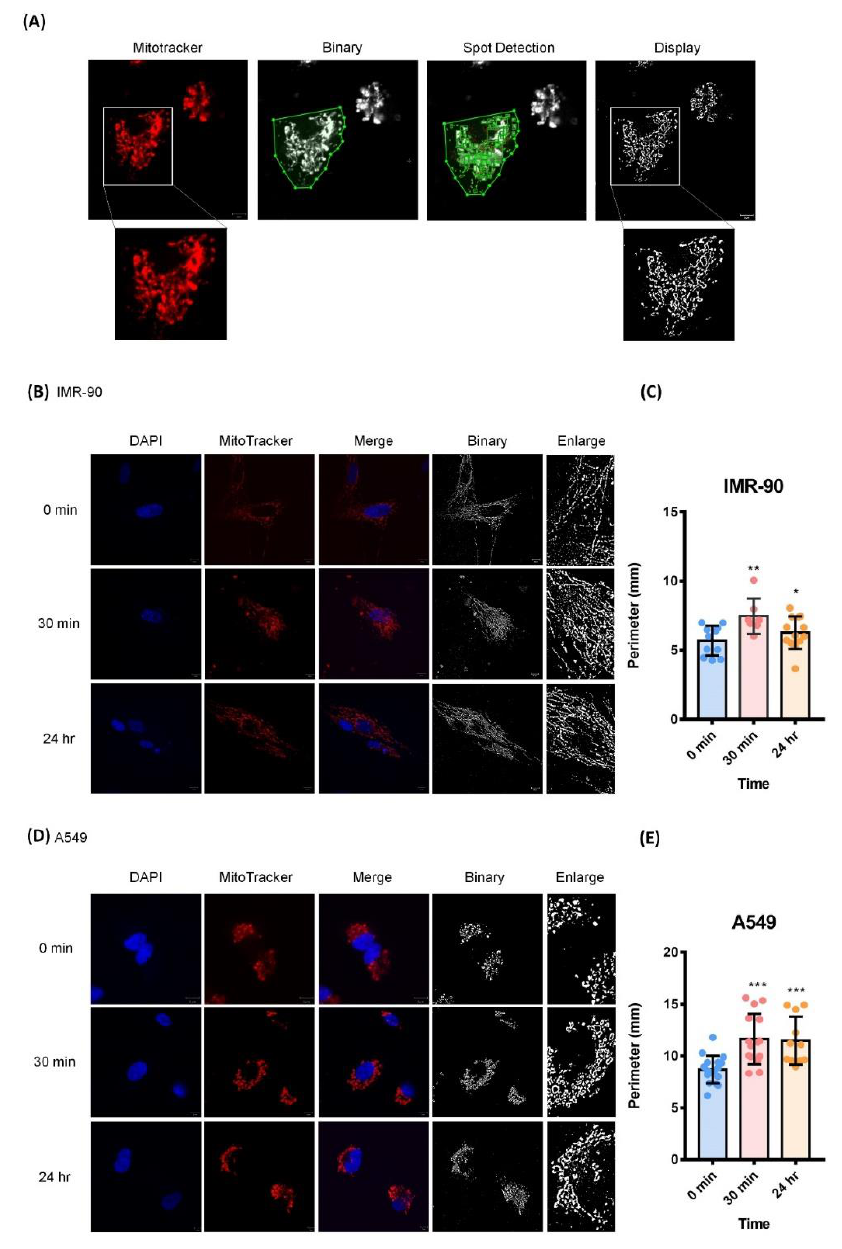
Figure 6. Mitochondrial lengths were enhanced by cyclic stretching. ( A ) A display of MitoTracker- stained images, binary images, the spot detection procedure, and the images after calculation. ( B ) The immunofluorescence images of stretched IMR-90. Mitochondria were stained with MitoTracker during stretching. Cells were fixed with 3.7% paraformaldehyde after stretching for di ff erent durations. The blue and red panels indicate cellular nuclei and mitochondria, respectively. ( C ) Statistical tests of mitochondrial perimeters, comparing the static and stretched groups in IMR-90. *, **, and *** mean a p -value < 0.05, < 0.01, and < 0.005, respectively. ( D ) The immunofluorescence image of stretched A549. The blue and red panels indicate cellular nuclei and mitochondria, respectively. ( E ) Statistical tests of mitochondrial perimeters, comparing the static and stretched groups in A549. *, **, and *** mean a p -value < 0.05, < 0.01, and < 0.005,